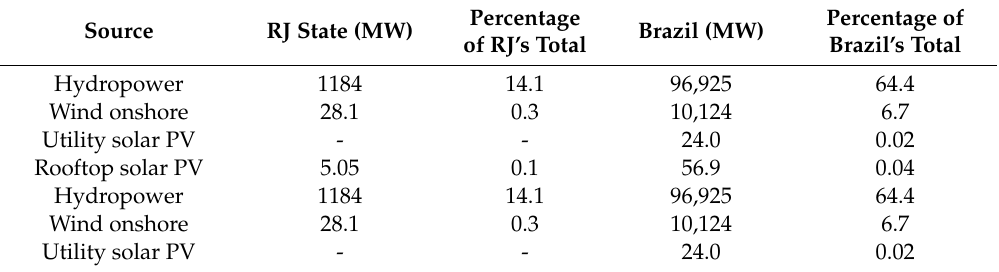
Table 2. Renewable electricity generation’s installed capacity: RJ state and Brazil—2016. Source: